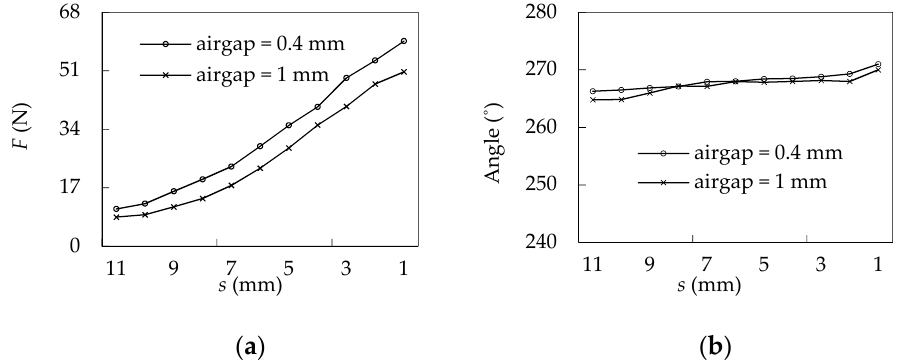
Figure 9. The effect of the air gap on EF (in the non-centerline, ratio = 2, L = 0.03 mm): ( a ) the amplitude curve; ( b ) the phase curve.